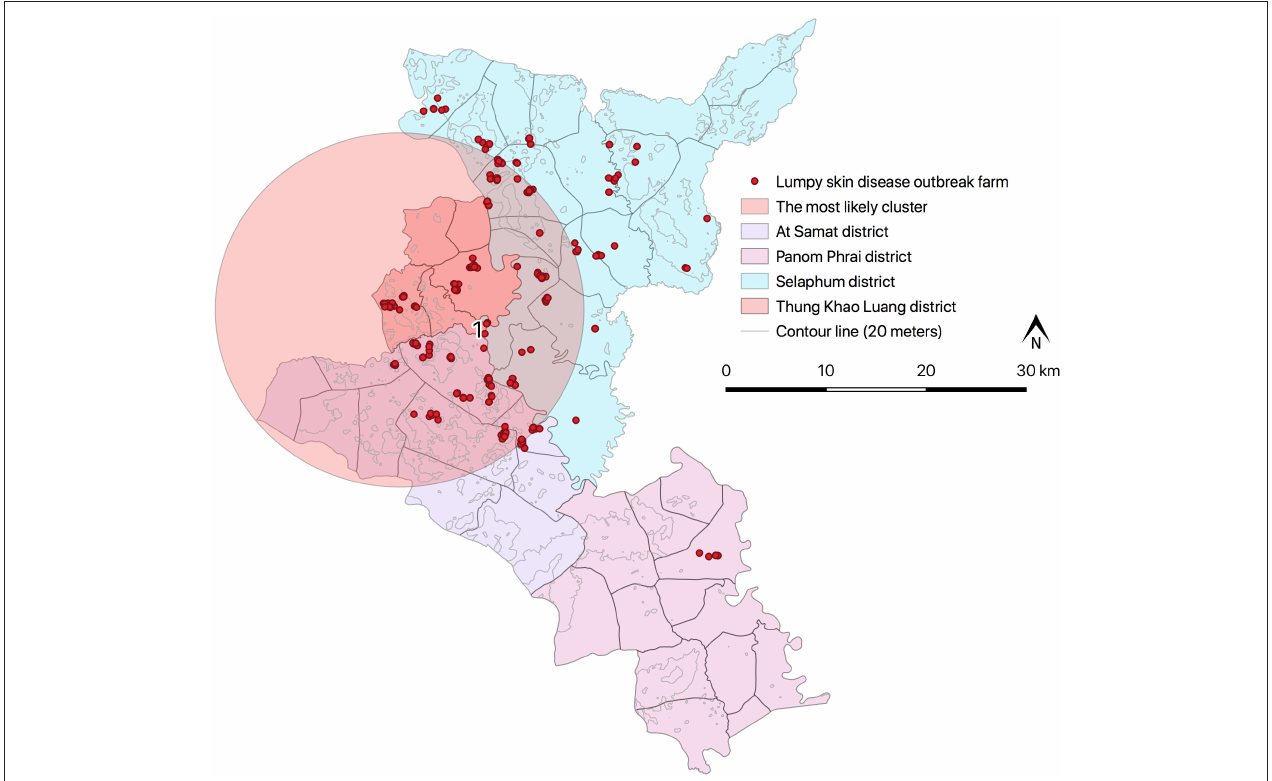
FIGURE 5 | Spatio-temporal clusters of lumpy skin disease identified by Poisson space-time model.